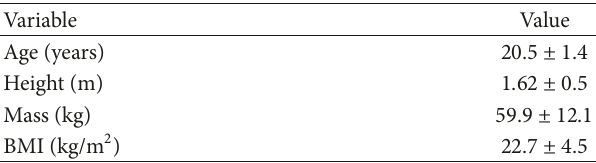
Table 1: Body mass index (BMI), age, height, and mass of the volunteers. m: meters; kg: kilograms; bpm: beats per minute; ms: milliseconds; mmHg: millimeters of